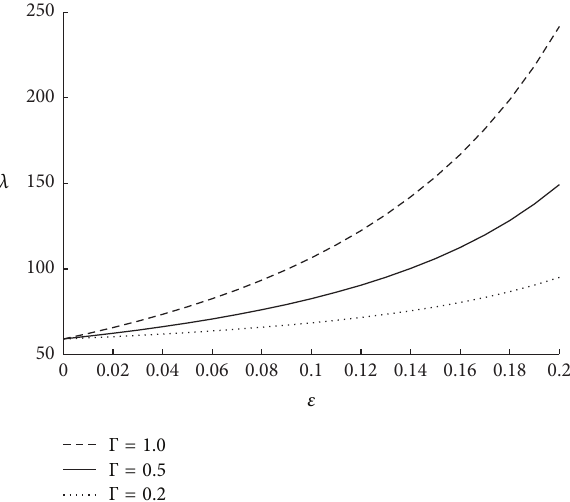
Figure 2: The variation of impedance with respect to 𝜙 when 𝑁 = = 0.1 , and 𝑢 = 0.01 . Figure 3: The variation of impedance with respect to 0.75 , 𝑚 = 50 , Γ = 0.5 , 𝑟 𝑐